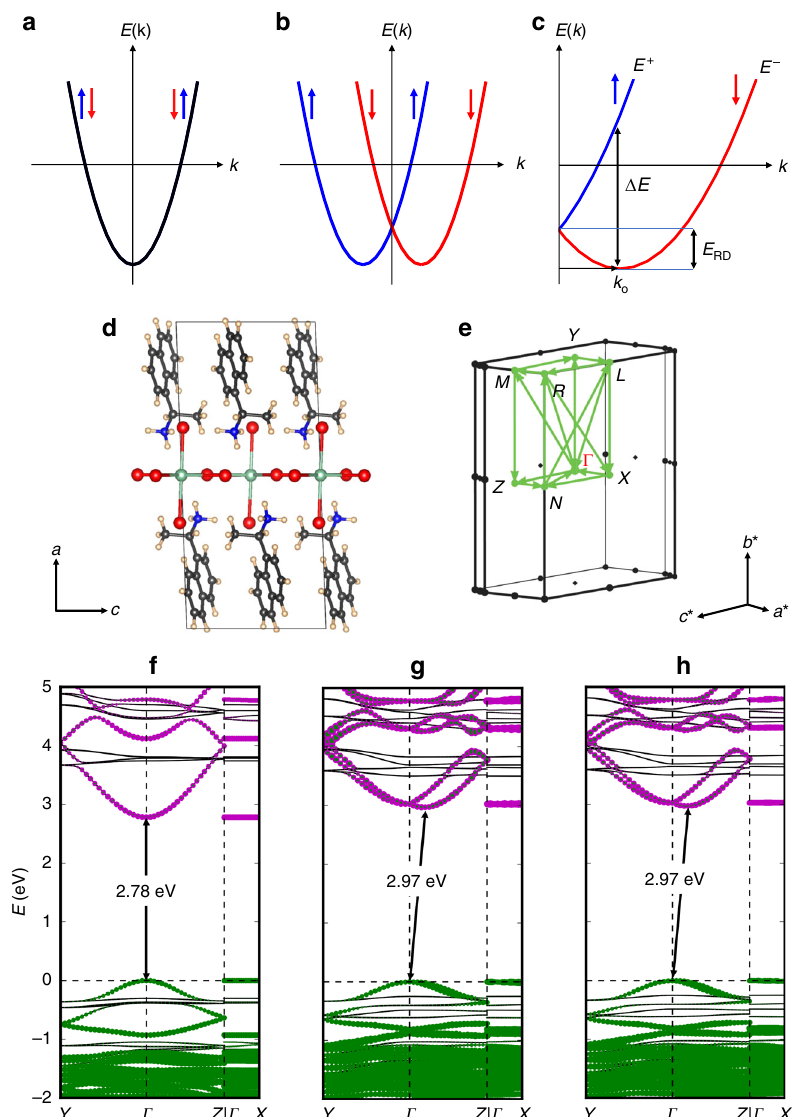
Fig. 3 RD spin-splitting in chiral NPB. a Schematic representation of a two-fold spin-degenerate electronic band in a conventional semiconductor. b , c Spin-polarized sub-bands (red: down spin; blue: up spin) separated in k-space due to the SOC and inversion asymmetry along one dimension of an RD semiconductor. E þ and E (cid:2) denote the inner and outer spin-polarized branches created by the RD spin-splitting. Δ E denotes the energy difference between the two branches at the characteristic momentum ( k 0 ), and E RD is the characteristic RD energy. d A representative unit cell of the relaxed S -NPB structure in real space and e , its Brillouin zone showing the k-path in reciprocal space used for band plotting in f – h . For the theoretical structures, cell axes were chosen to be consistent for racemic, R - and S -NPB such that the stacking direction is always along the a -direction, and the inorganic layers are parallel to the b – c plane. f – h , The computed DFT + HSE06 electronic band structures of f racemic-NPB, g S -NPB, and h R -NPB shown along selected k-paths. The atomic contributions to the electronic continuum bands are identi fi ed for Pb (magenta), Br (green), and organic-derived (black) states. The two-fold spin- degenerate lowest conduction band in f racemic-NPB splits into upper and lower branches in both g S -NPB and h R -NPB mainly along the Γ – Z direction of reciprocal space due to inversion asymmetry in the [PbBr 4 ] 2 − perovskite layers of S -NPB and R -NPB. Full band structures of R -, S -, and racemic-NPB for all the k-paths are presented in Supplementary Fig.